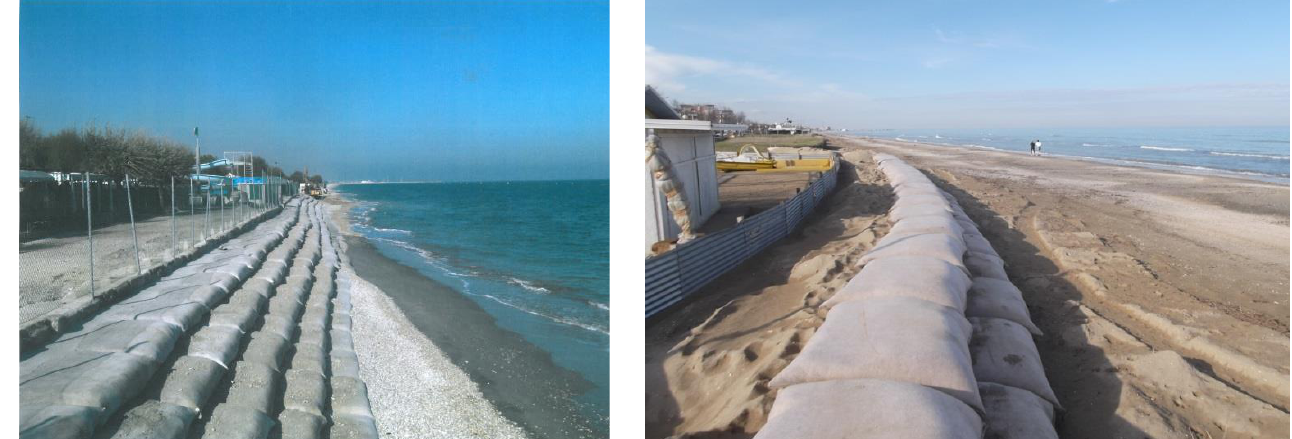
Figure 1. Application of “Stopwave” as coastal revetments: Grottammare, Italy ( left panel ) and Senigallia, Italy ( right panel ).